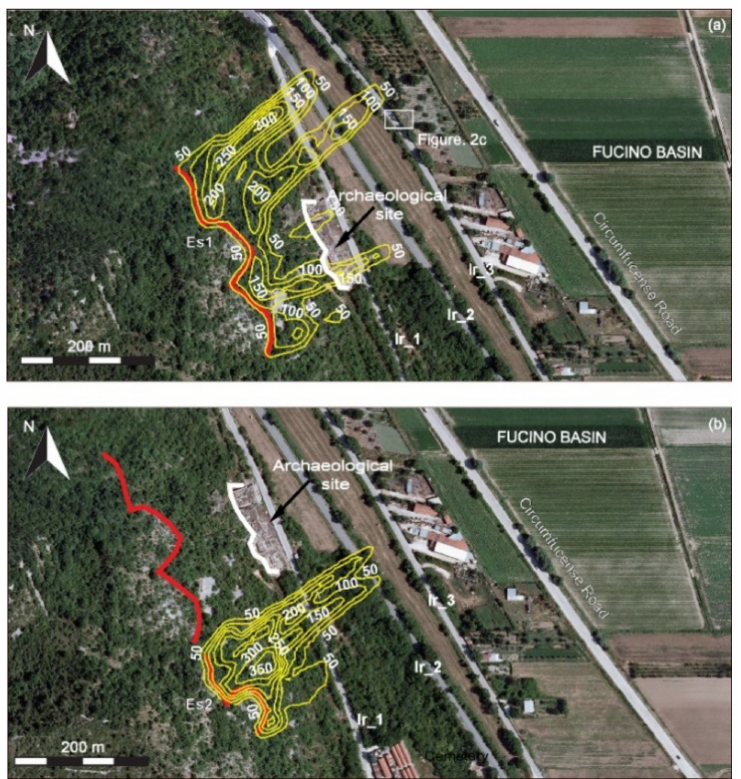
Figure 9. Specific kinetic energies e k map (m 2 /s 2 ) for rockfall simulations from escarpment: ( a ) Es1;